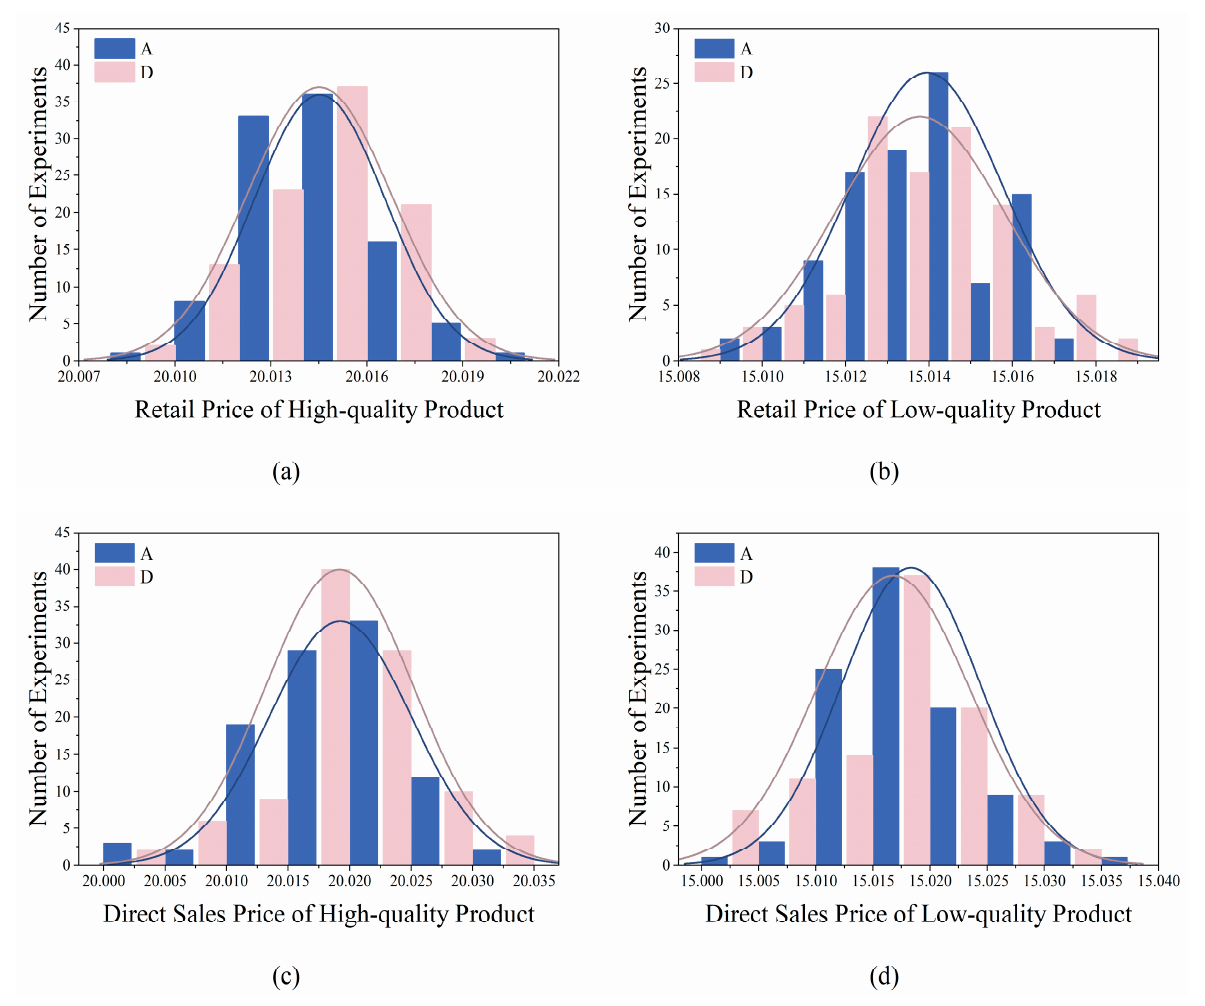
Figure 12. Prices in A and D of: ( a ) high-quality product in retail channel; ( b ) low-quality product in retail channel; ( c ) high-quality product in direct sales channel; ( d ) low-quality product in direct sales channel. ( t = 100). Table 6. Statistical test results for Scenario A and Scenario D prices.